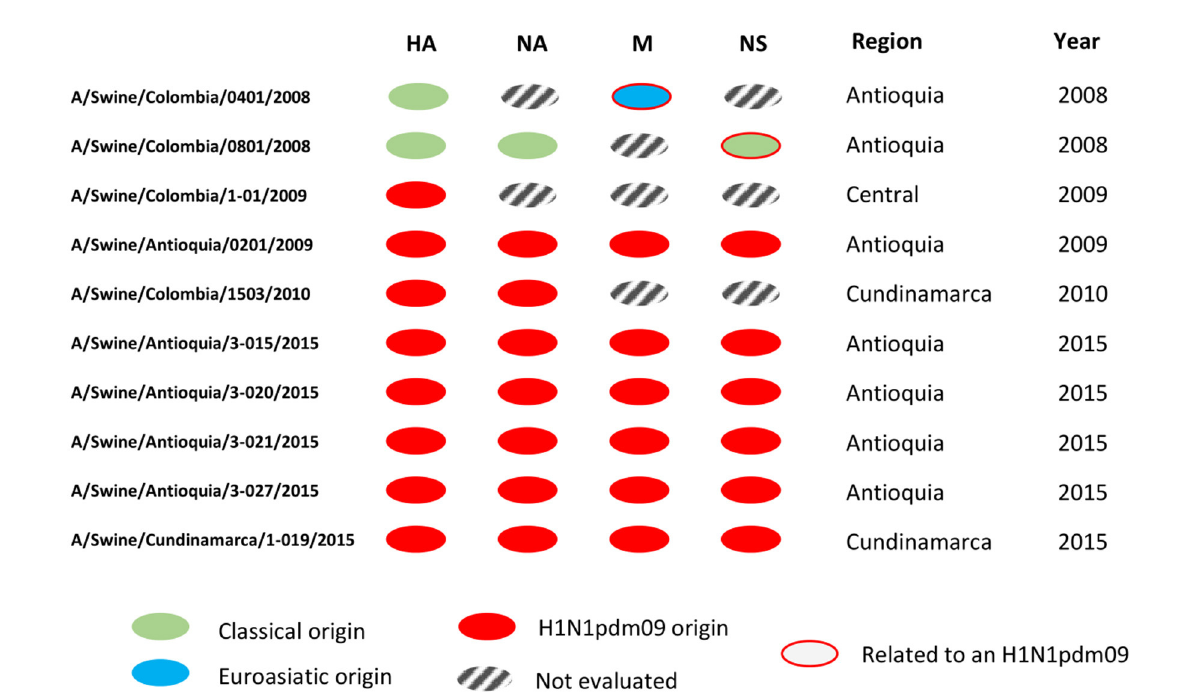
FIGURE5 Genomic segment constellations of Colombian swine influenza A viruses analyzed in this study. Genetic configurations of internal genes from H1N1pdm09 origin in the viruses identified as the H1N1 subtype.